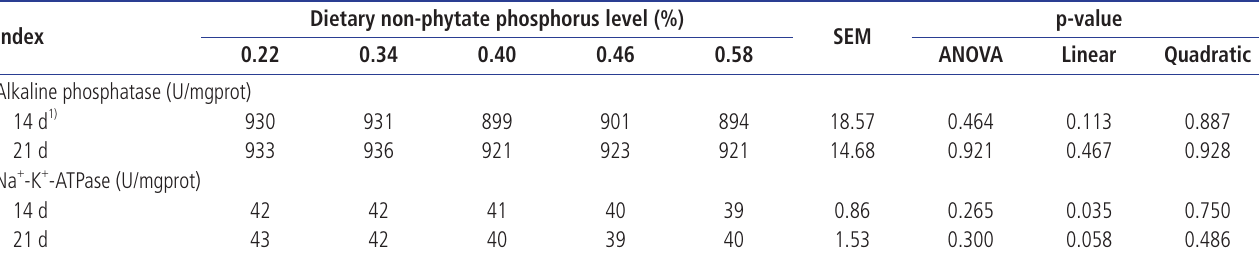
Table 5. Effect of dietary non-phytate phosphorus levels on jejunal enzyme activity of ducks